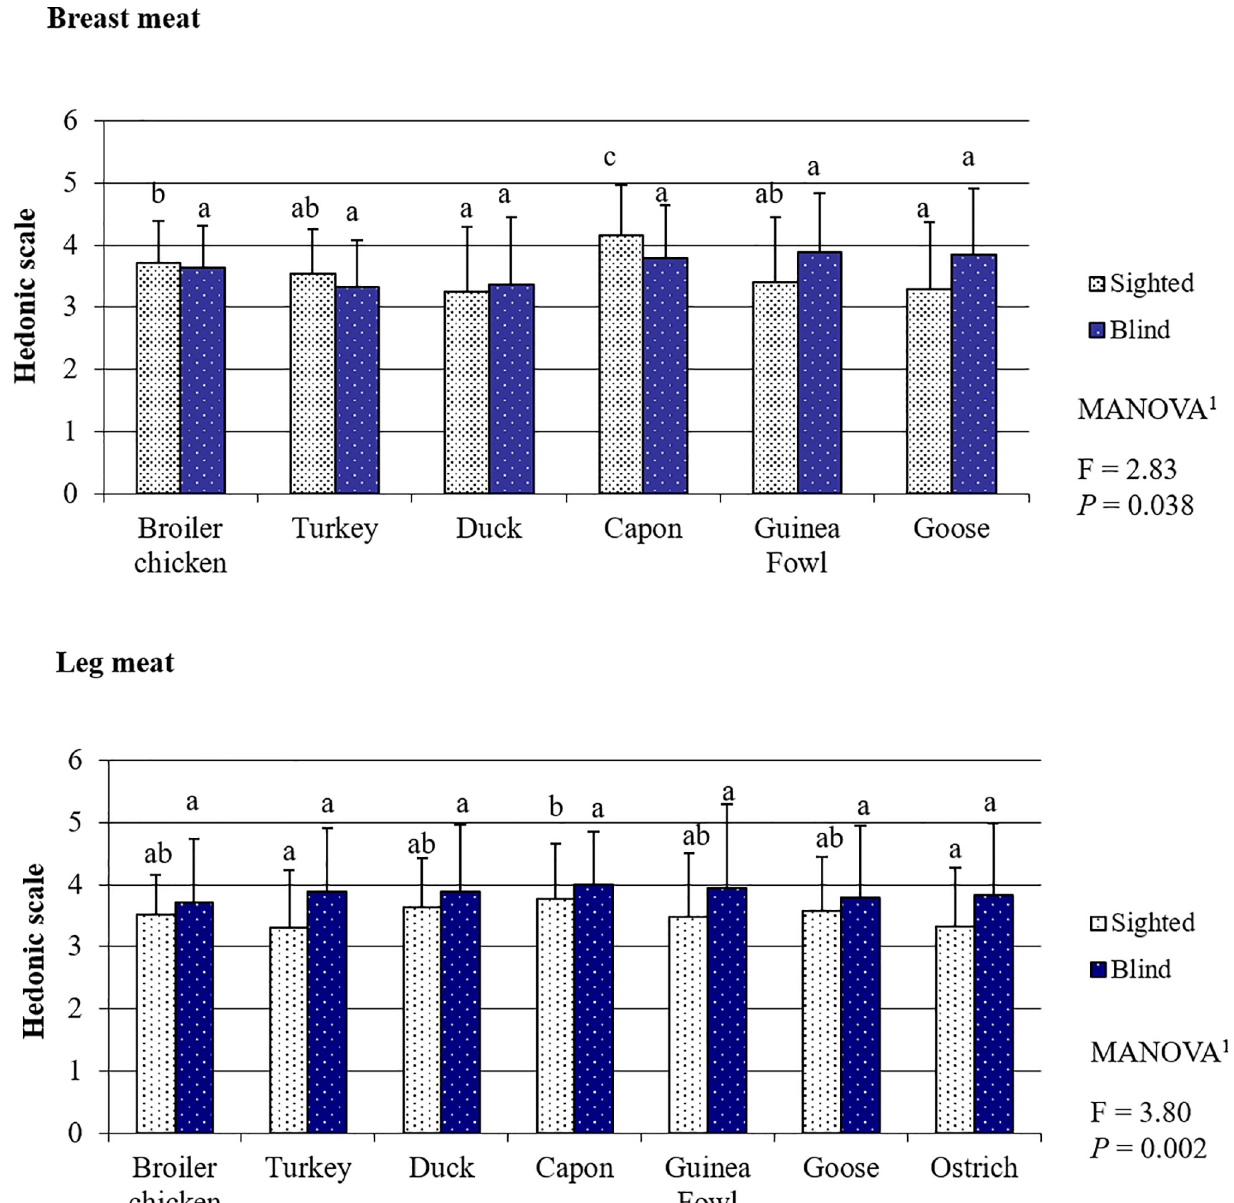
Fig 2. Poultry meat smell based on the evaluation by the sighted and blind panelists.